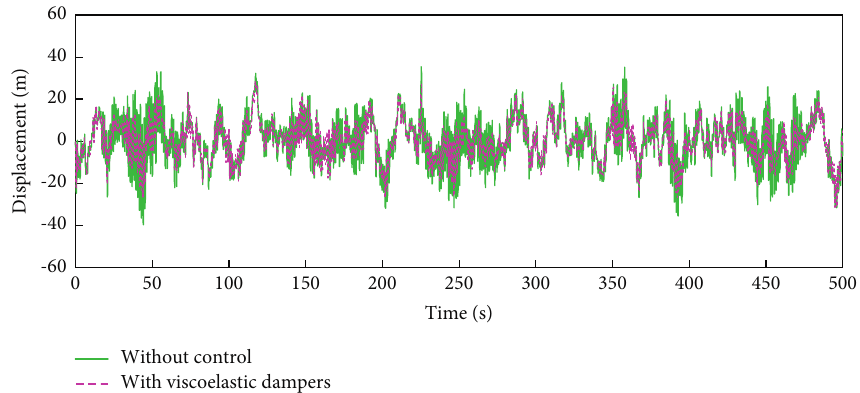
Figure 15: Variations of the first additional modal damping ratio ξ analysis method.